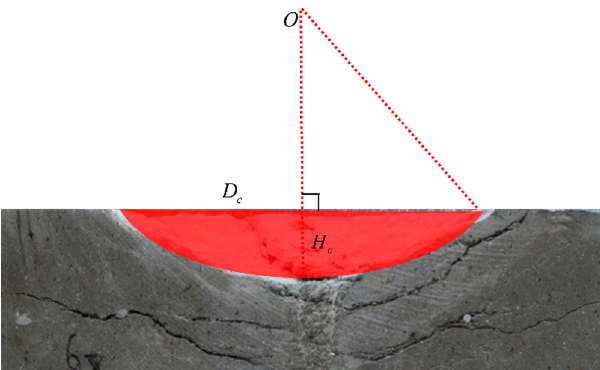
Figure 6. Sectional view of the typical crater for target #9 with a V 0 = 3083 m/s.